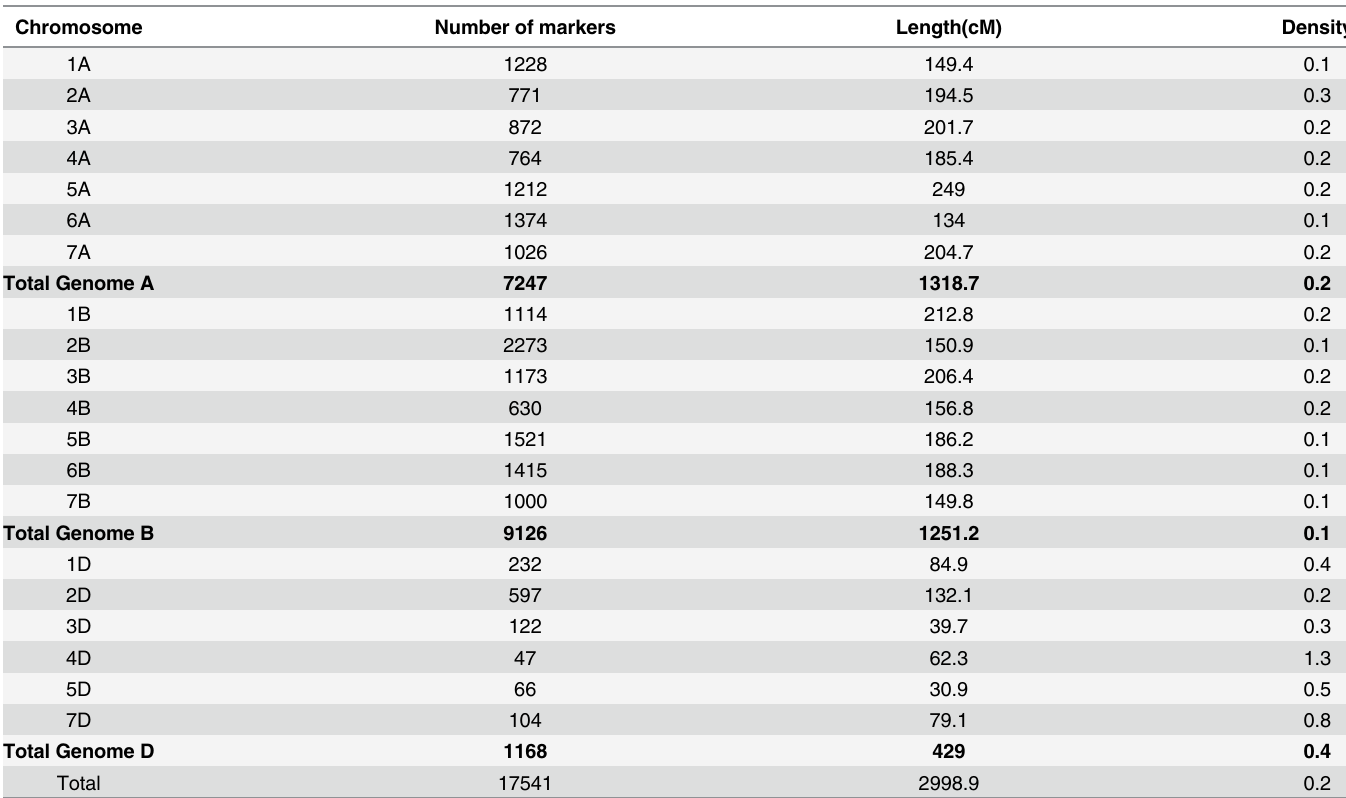
Table 3. Features of the consensus